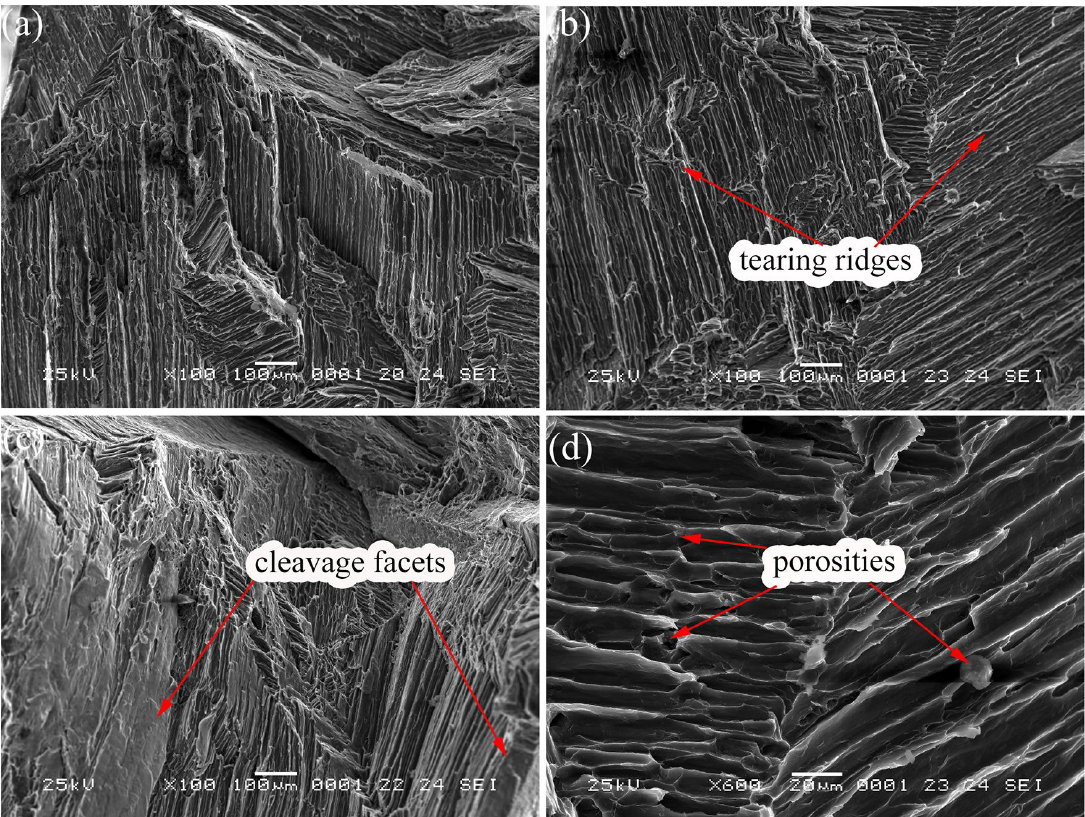
Figure 7. SEM micrographs of fractured tensile samples in the different regions of the casting: (a) top; (b) center; (c) bottom; (d) zoom in of image